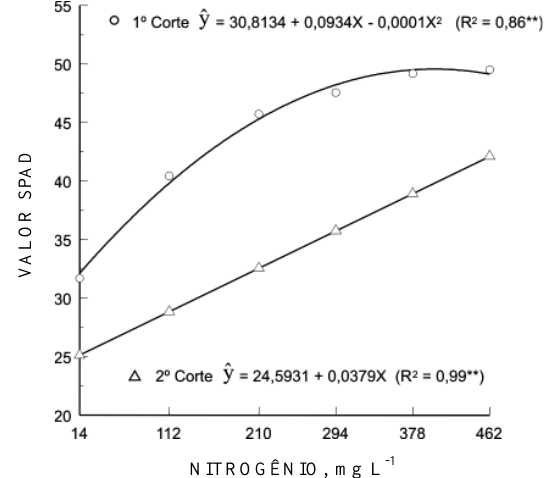
Figura 1. Valores SPAD em lâminas de folhas recém- expandidas (LR) do capim-Aruana, no primeiro e segundo corte, considerando as doses de N em solução